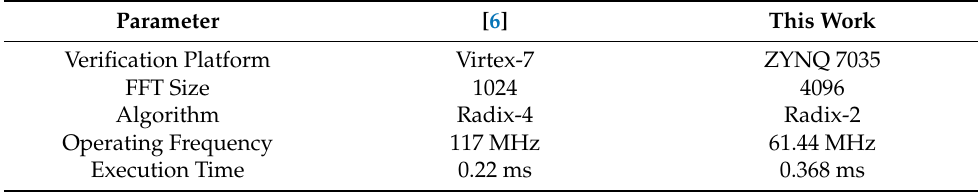
Table 2. Comparison of simulation results.